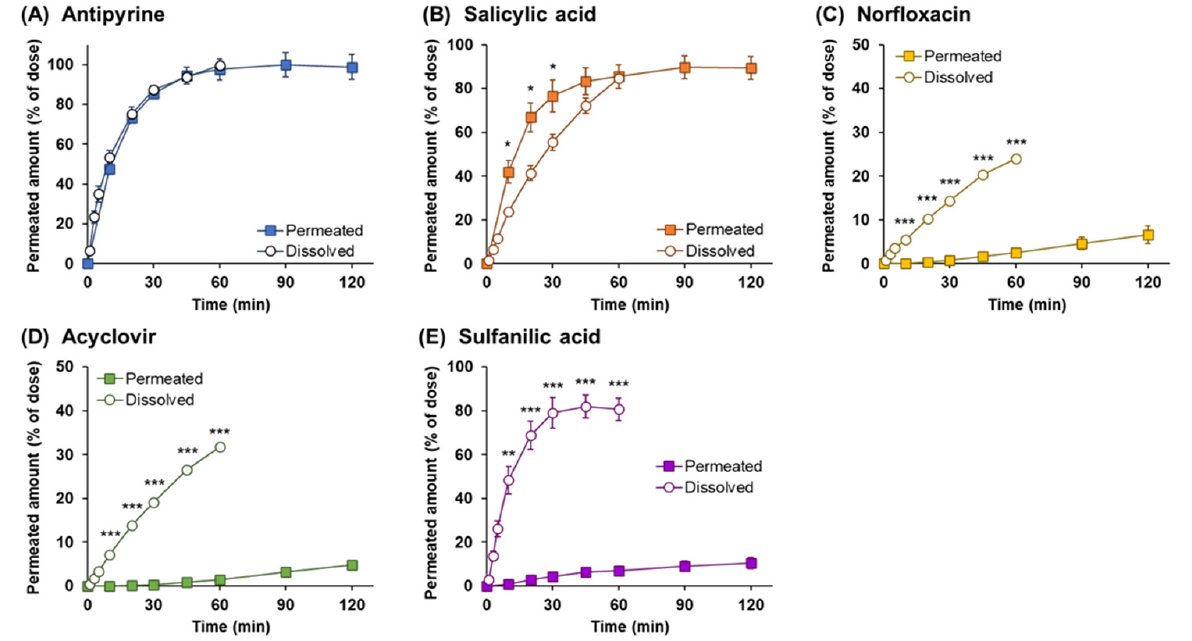
Figure 5. Profiles of powder dissolution and drug permeation following powder application for five model drugs: ( A ) antipyrine, ( B ) salicylic acid, ( C ) norfloxacin, ( D ) acyclovir ( E ), and sulfanilic acid. The data on the dissolution for ANF ( ○ ) were derived from the dissolution study using in vitro evaluation system (Figure 2), and the data on the powder dissolution and drug permeation ( ■ ) were derived from the Calu-3 permeation test following powder application (Figure 4A). The data are represented as the mean of independent experiments, with the vertical bars indicating the S.E. (n = 3–5). Statistical significances are represented in *** p < 0.001, ** p < 0.01, and * p < 0.05 compared